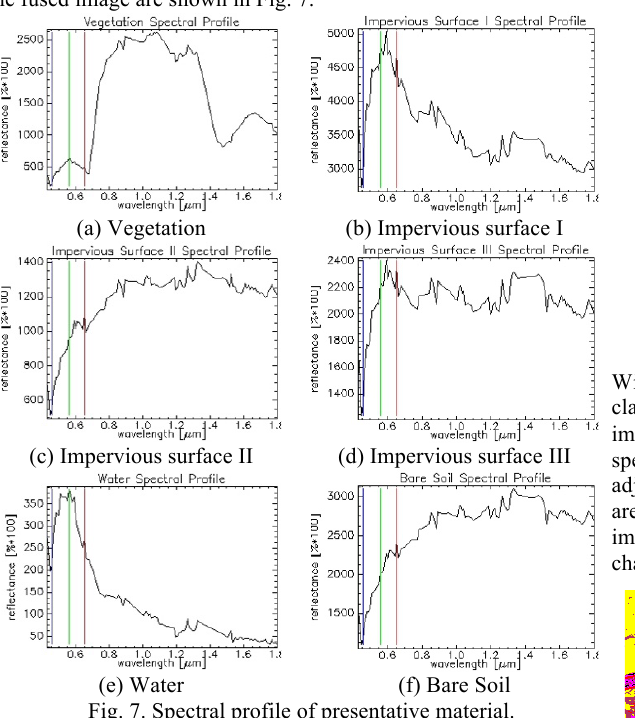
Fig. 7. Spectral profile of presentative material.